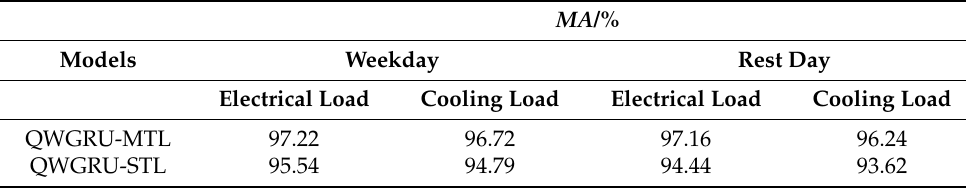
Table 3. Comparison of the effects of multi-task learning and single task learning.